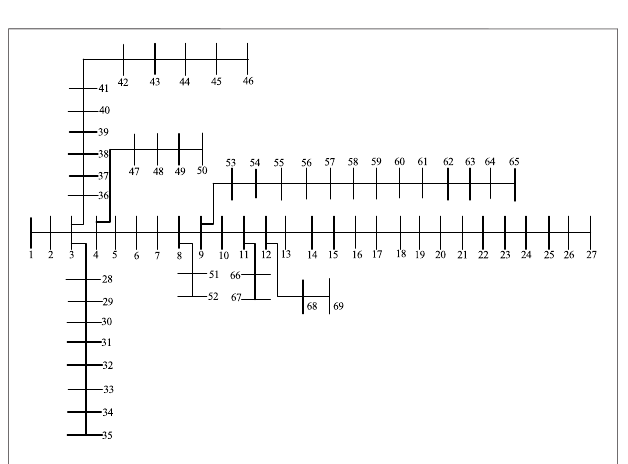
FIGURE 5 | IEEE 69-bus distribution